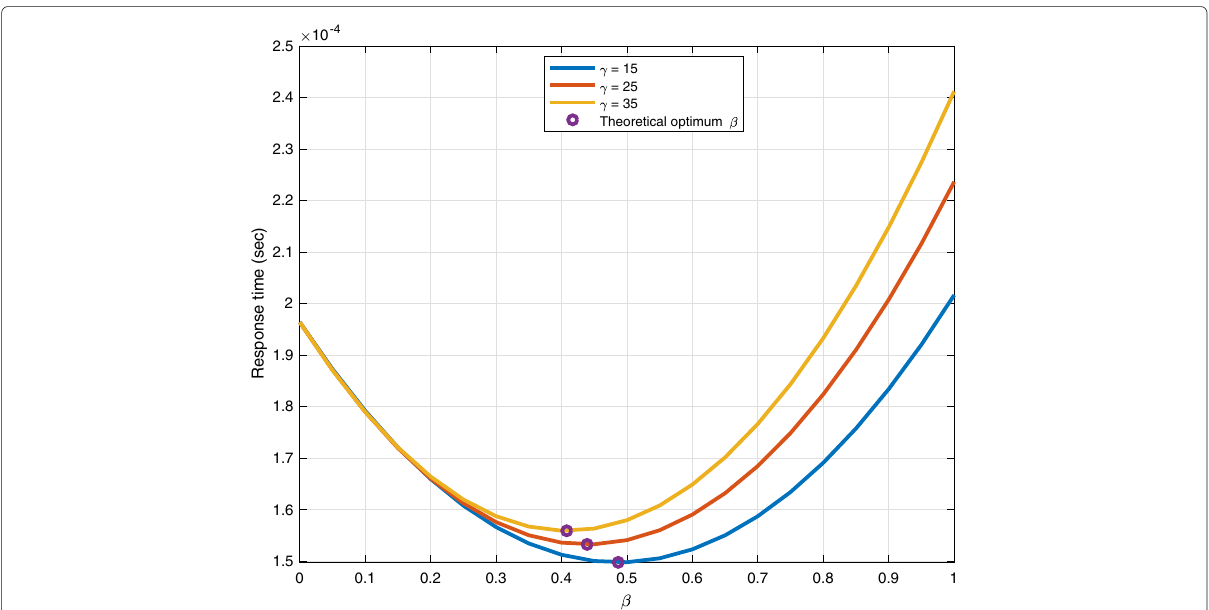
Fig. 12 Comparison of optimum β values while γ is changing and λ = 2000. γ = 15, γ = 25, γ = 35, Theoretical optimum β